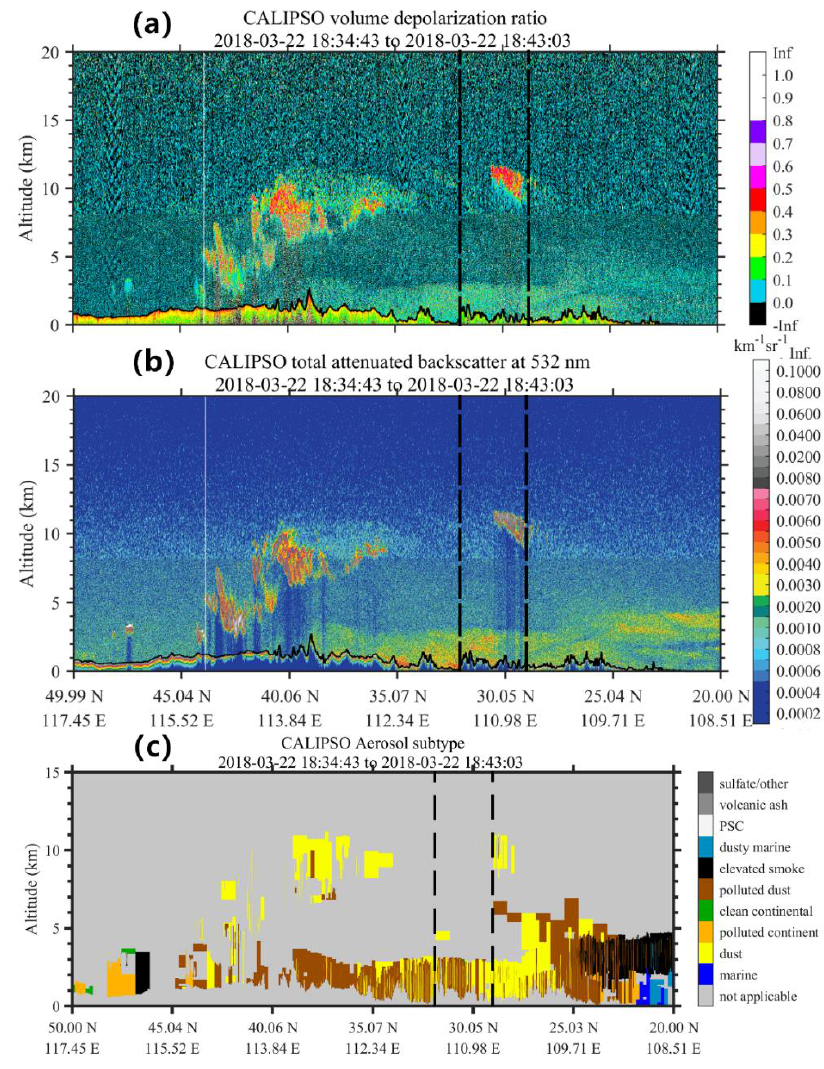
Figure 10. CALIOP level-1B 532-nm total attenuated backscatter data ( a ), CALIOP level-1B 532-nm volume depolarization ratio ( b ), and level-2 vertical feature mask ( c ) on 22 March 2018. The orbit crosses the research area from 18:34:43 to 18:43:03 UTC.